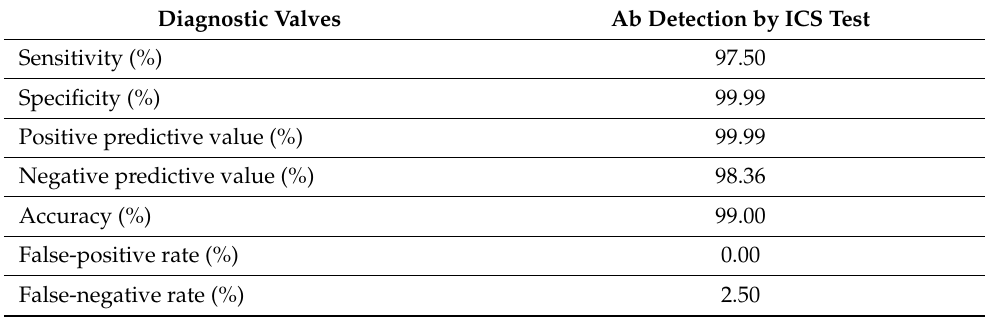
Table 3. Diagnostic values of the immunochromatographic strip test for fasciolosis